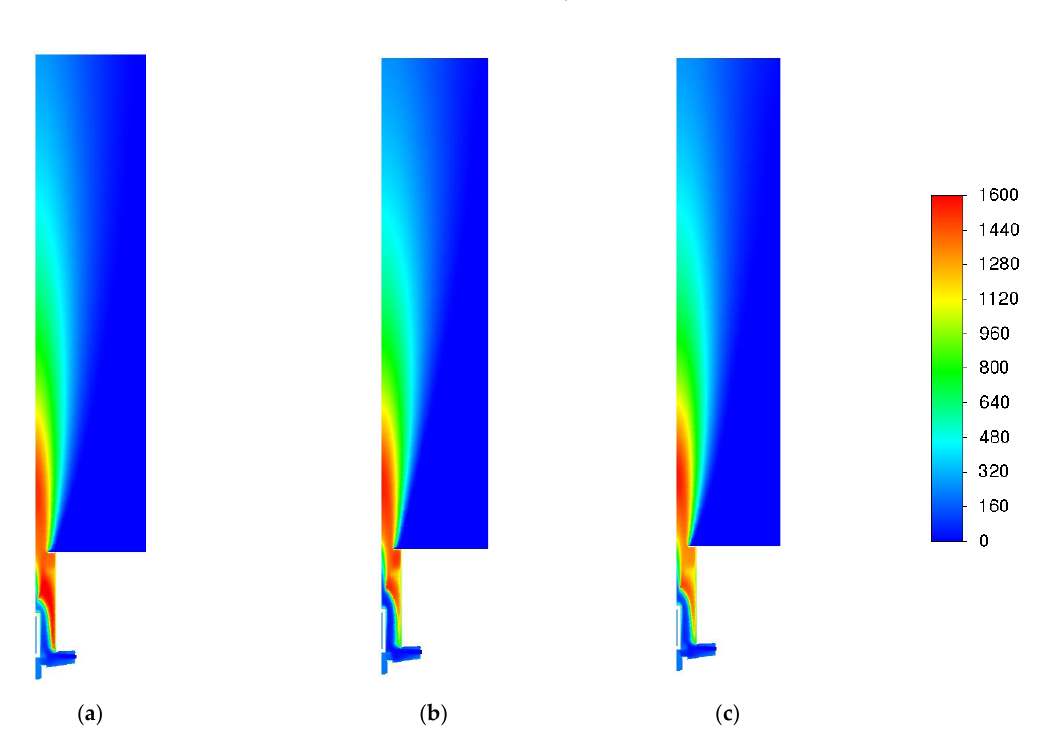
Energies 2022 , 16 , 25 Figure 5. Streamlines, m/s (limited by the value of 20 m/s): ( a ) k-e; ( b ) k-w SST; ( c ) RSM.